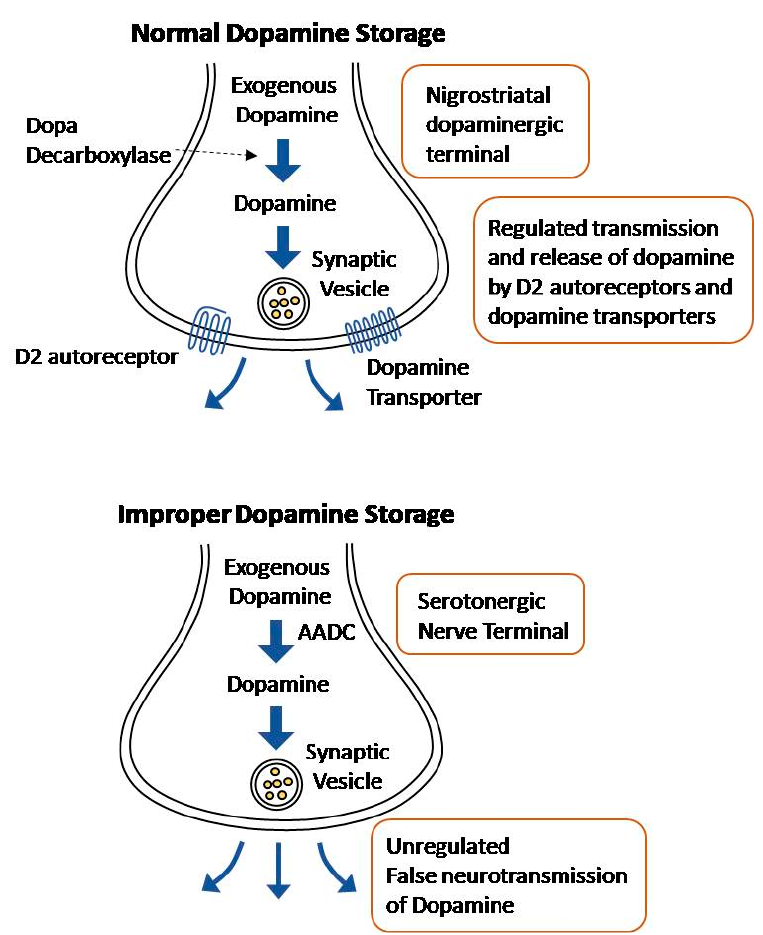
Figure 2. Illustration of Normal dopamine storage Vs improper dopamine storage.